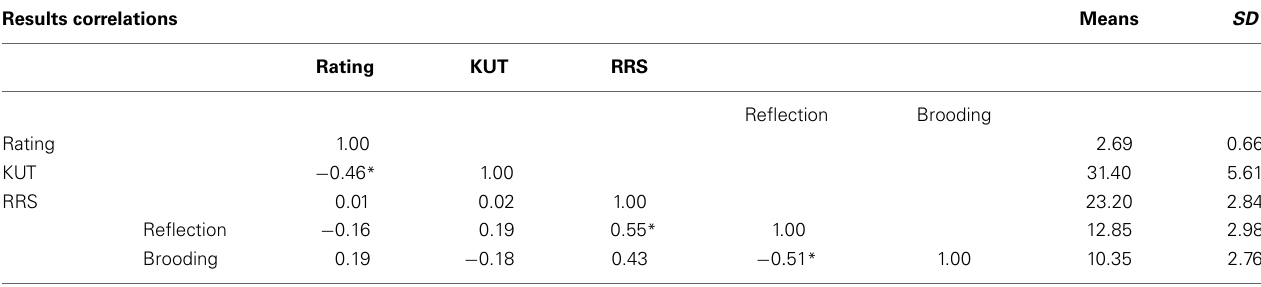
Table 1 | Correlation between performance rating, control beliefs, and rumination. Results correlations